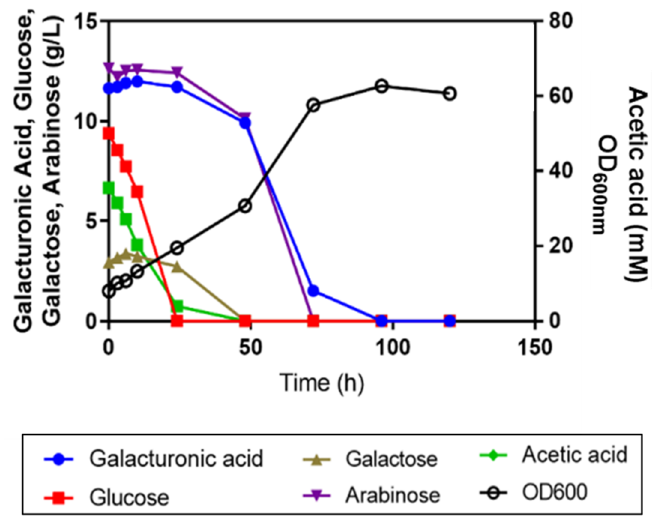
Figure 5. Performance of R. toruloides PYCC 5615 in SBP hydrolysate H11 supplemented with commercial YNB with ammonium sulphate and amino acids. Cultivation was performed at 30 ◦ C with orbital agitation (250 rpm). The initial culture OD 600 nm was 8.